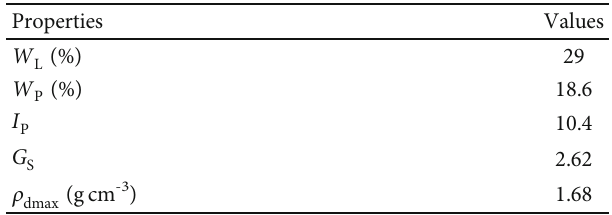
Table 1: Physical properties of kaolin clay.